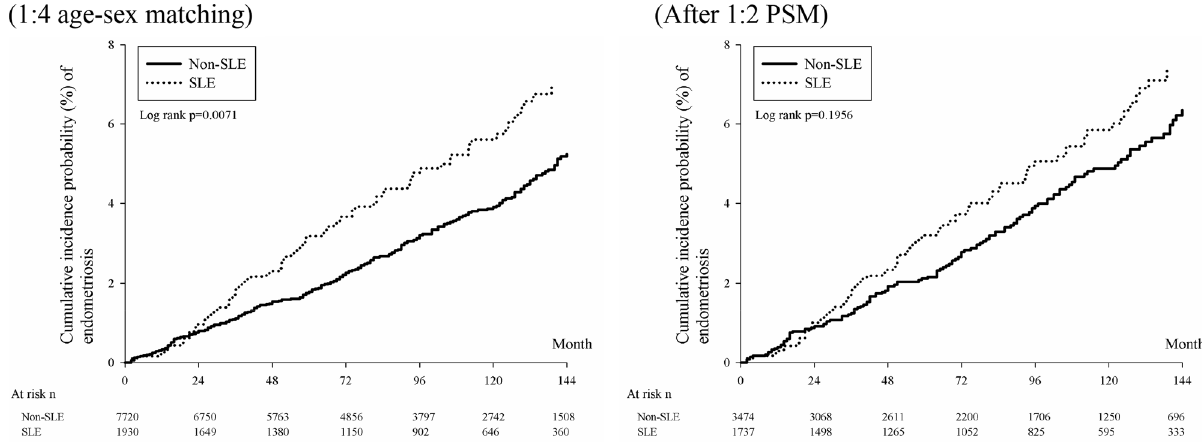
Figure 3. The cumulative incidence curves of endometriosis were plotted by the Kaplan–Meier